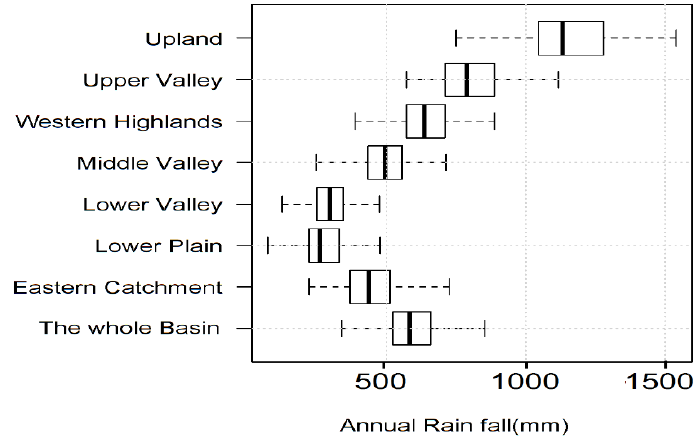
Figure5. Figure 5. Box plot showing the variability of annual rainfall over the study areas for the period 1900 – 2016.